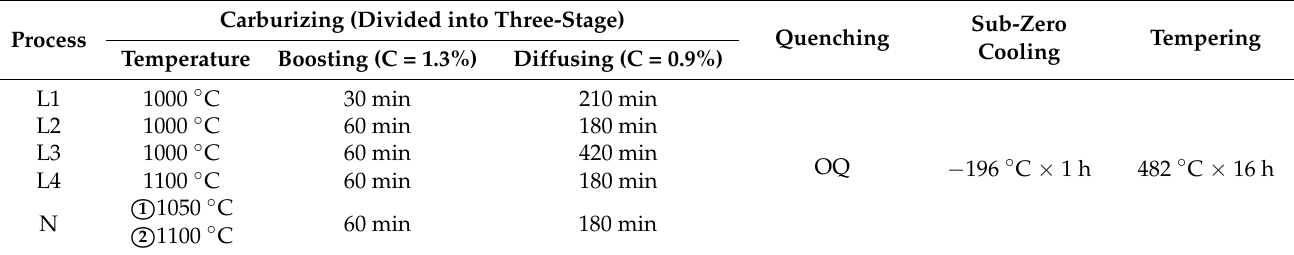
Table 2. Carburizing